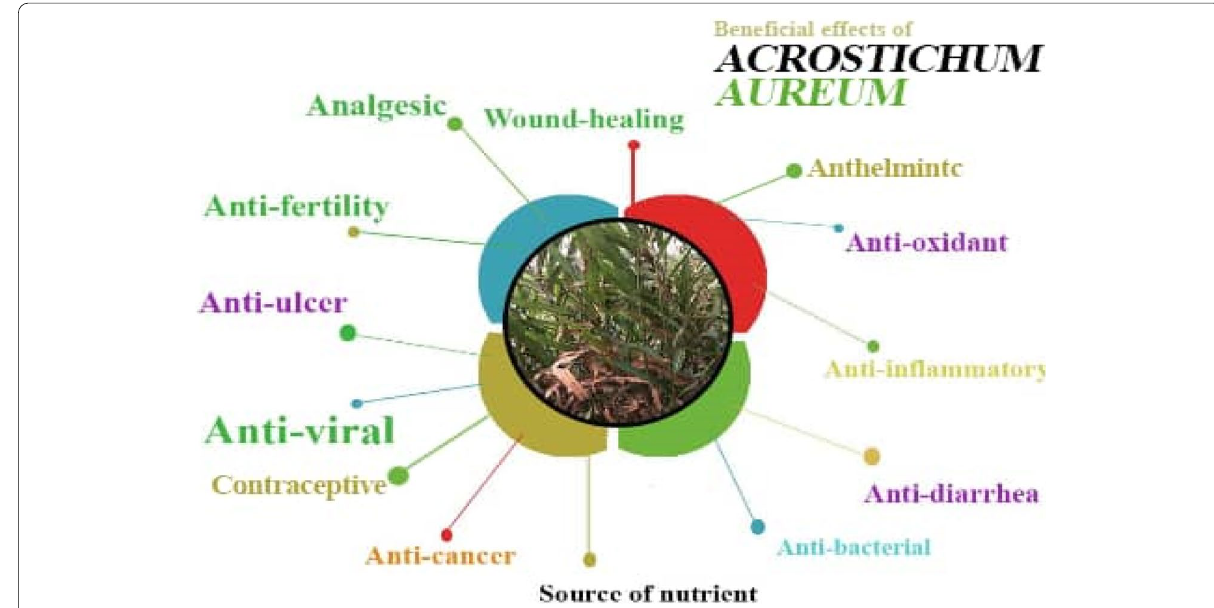
Fig. 4 Biological activities of Acrostichum